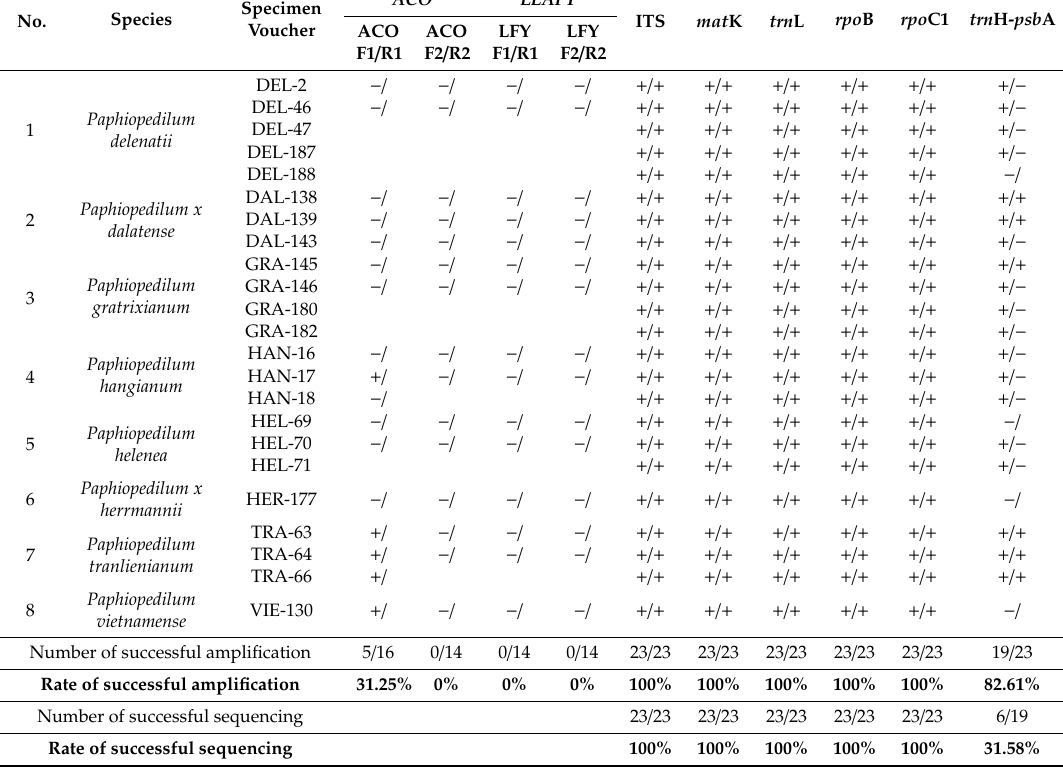
Table 2. Amplification and sequencing results of eight loci on eight Paphiopedilum endemic species (dataset